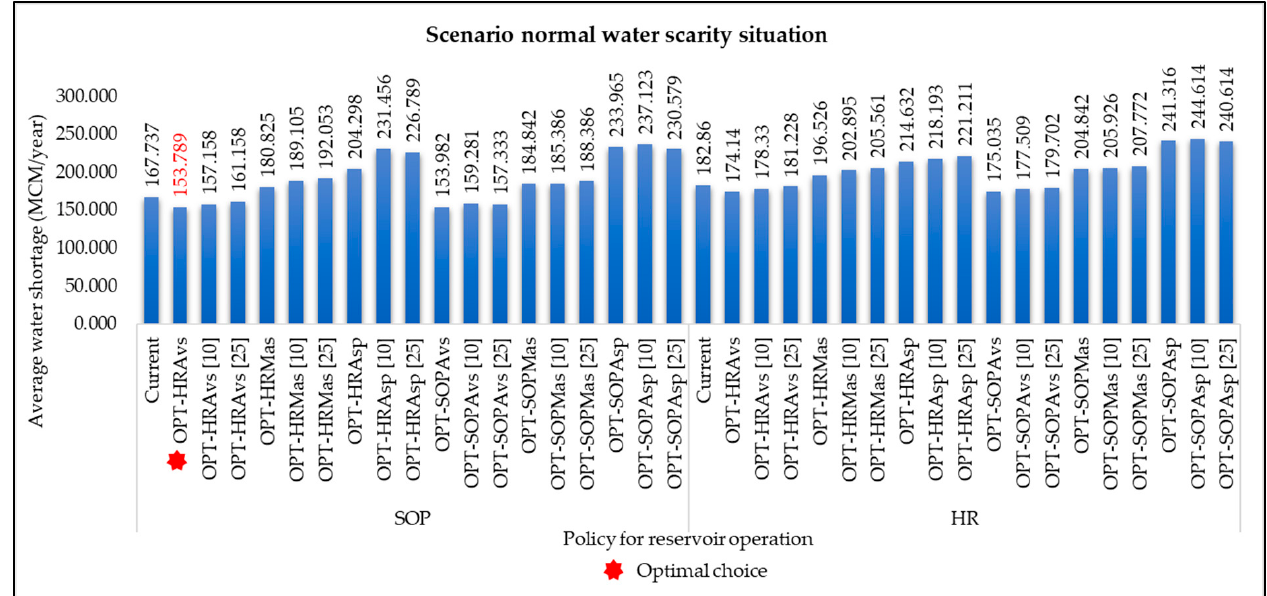
Figure 8. Optimal choice for operating rule curves under normal water scarcity scenario.